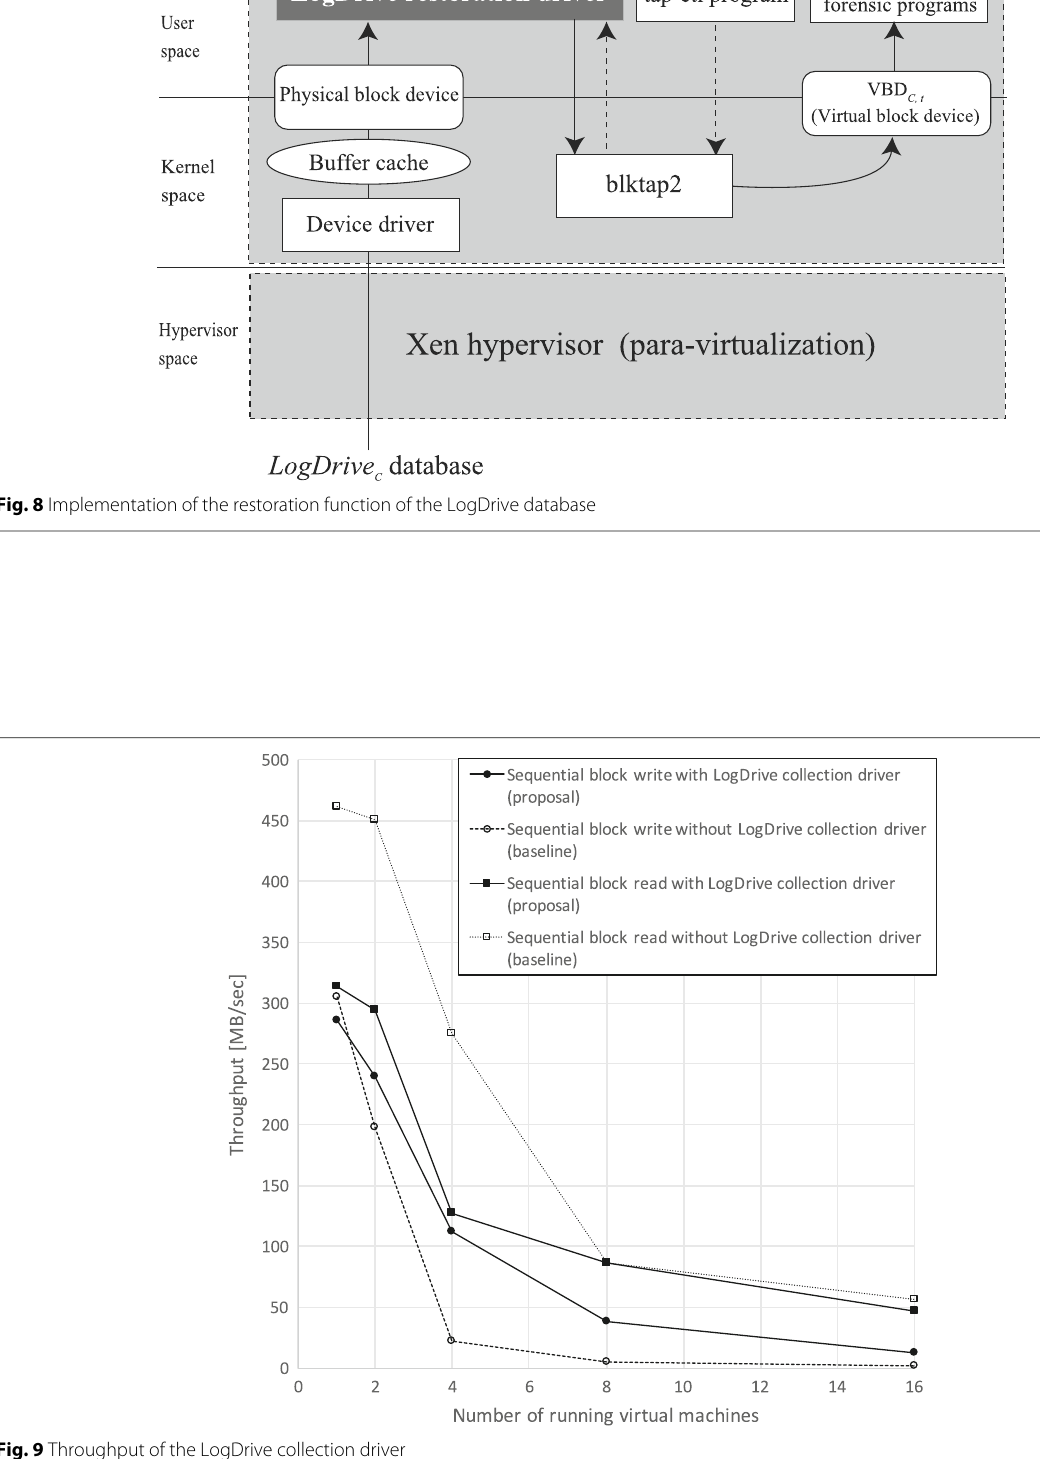
Fig. 9 Throughput of the LogDrive collection